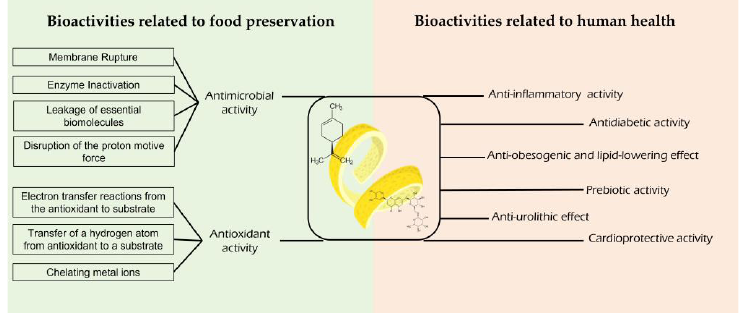
Figure 2. Outline of the main bioactivities of lemon by-products related to food preservation and human health with focus on the mechanisms of action of antimicrobial and antioxidant activity.